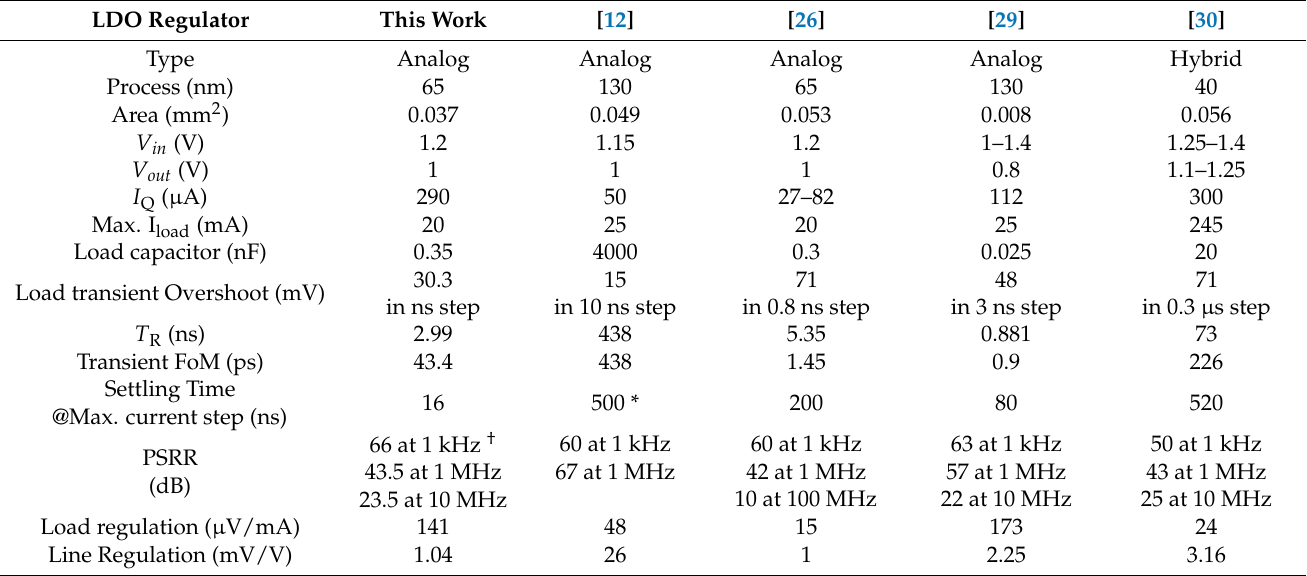
* Estimated from figure. †